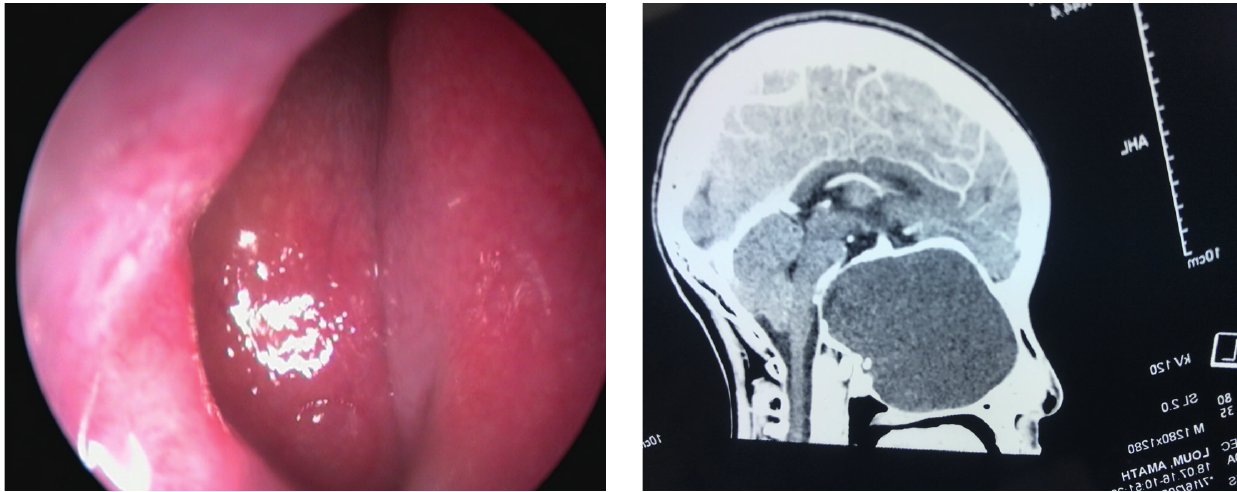
Figure 1. Mass filling the right nasal cavity. Figure 2. Sphenoid mass extending to the nasal